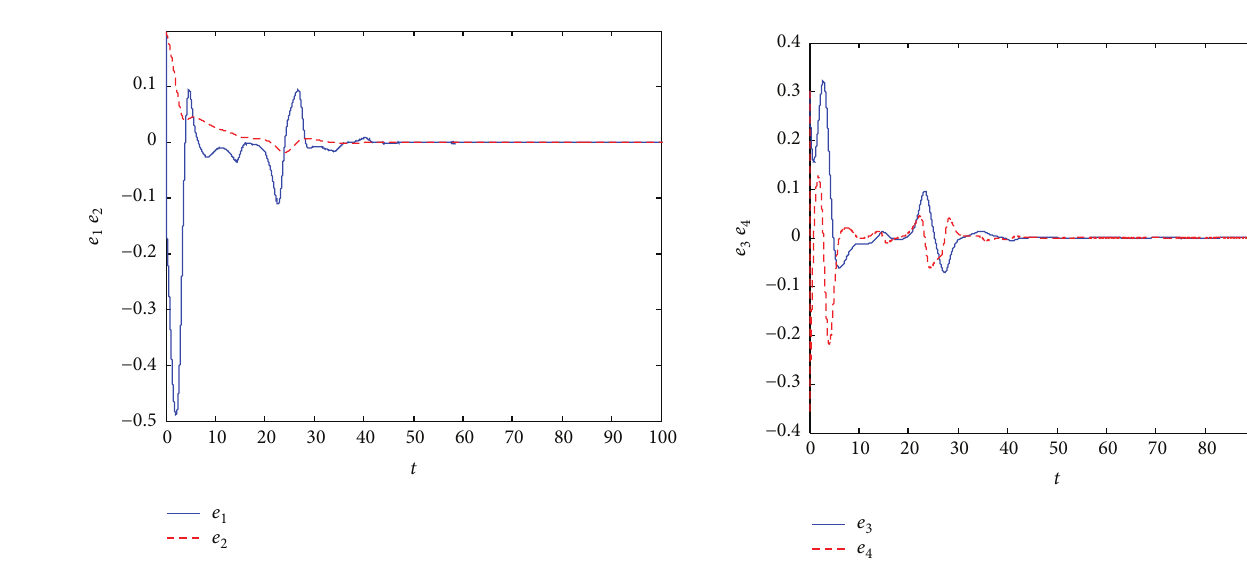
Figure 1: Error signals between the pair of Van der Pol system. Figure 2: Error signals between the pair of Willis